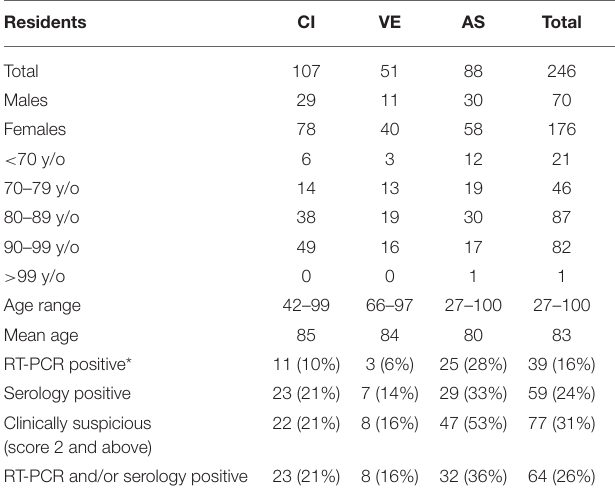
TABLE 1 | Data of 246 residents of three nursing homes (CI, VE, AS).